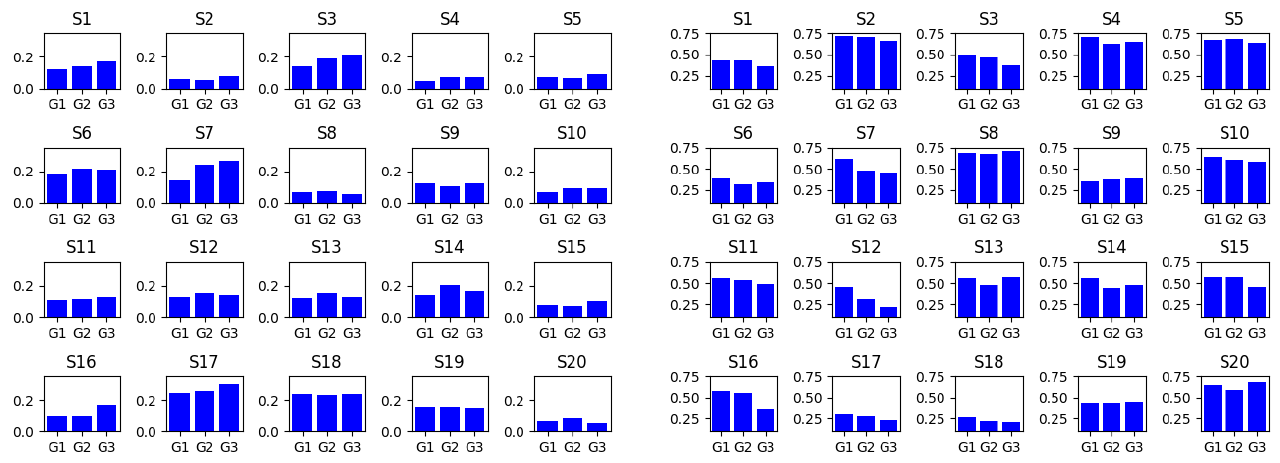
Fig. 6. Delta relative band powers in T4 from all subjects during gameplays Fig. 5. Beta relative band powers in T4 from all subjects during gameplays